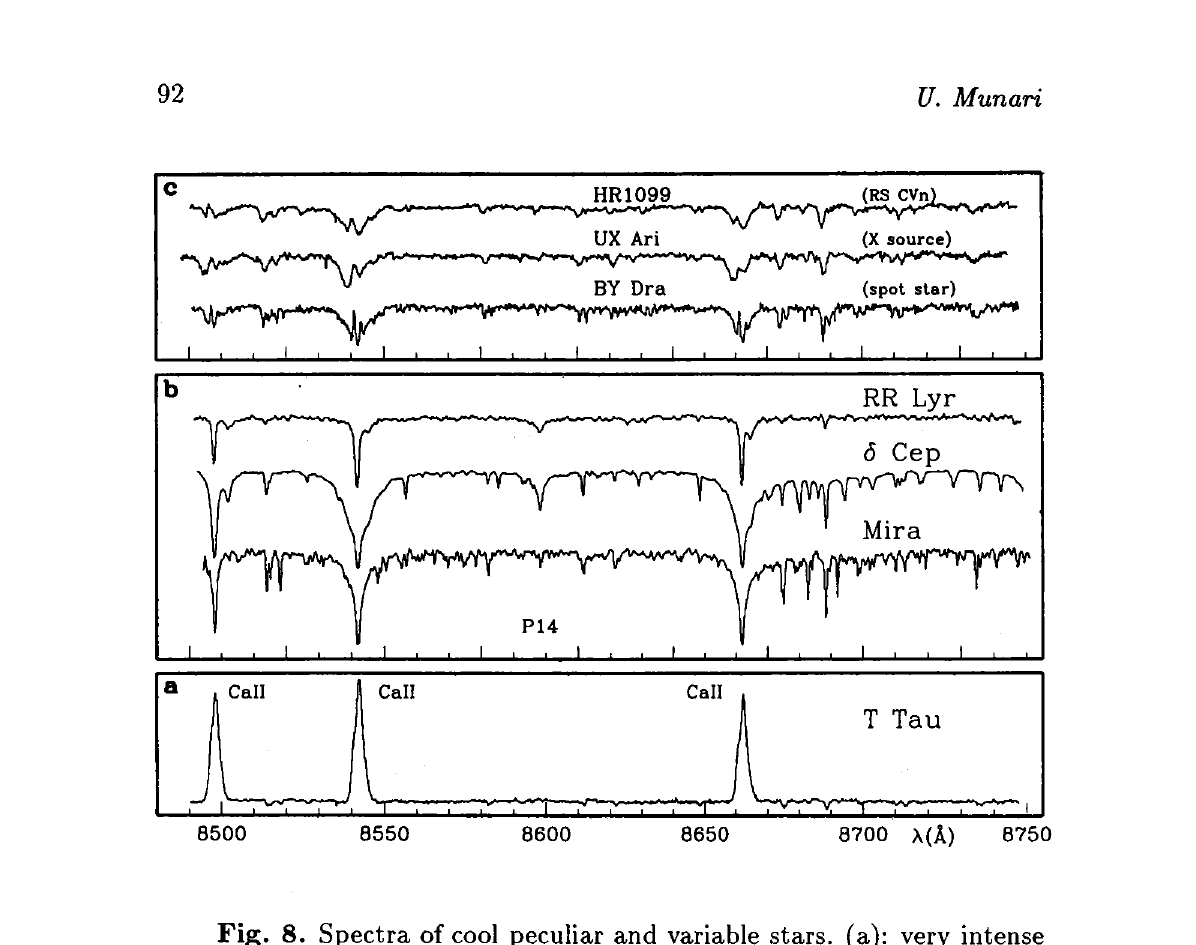
Fig. 8. Spectra of cool peculiar and variable stars, (a): very intense emission in the C a ll lines (but not in the Paschen lines) by the pre-main- sequence star Τ Tau; (b): zoomed-in spectra of the prototype pulsating stars; (c): zoomed-in spectra of representative active stars (emission in the cores of C a ll lines, but not in the Paschen